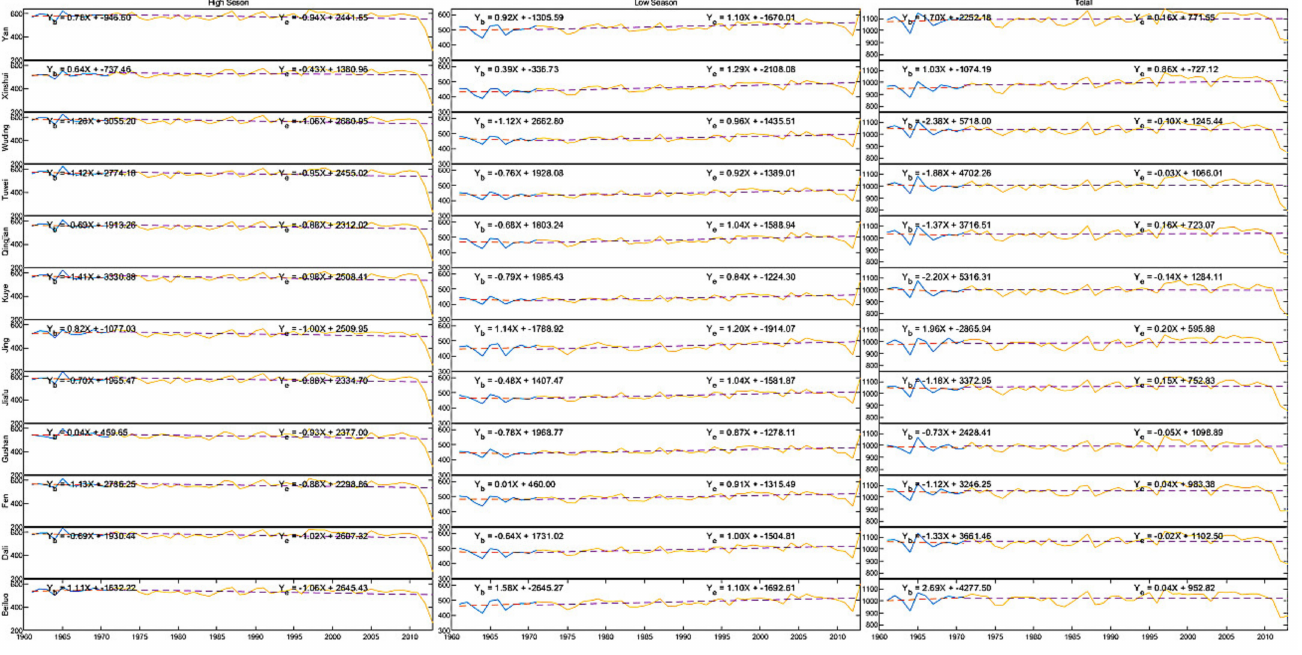
Figure A3. Time series of evapotranspiration change for 12 catchments at intra- and inter-annual scales. For Figures A1–A3, the time series for each time period is marked by different colors (blue lines for baseline period and yellow lines for evaluation period) and is fitted by linear regression model separately (subscript b refers to baseline period and subscript e refers to evaluation